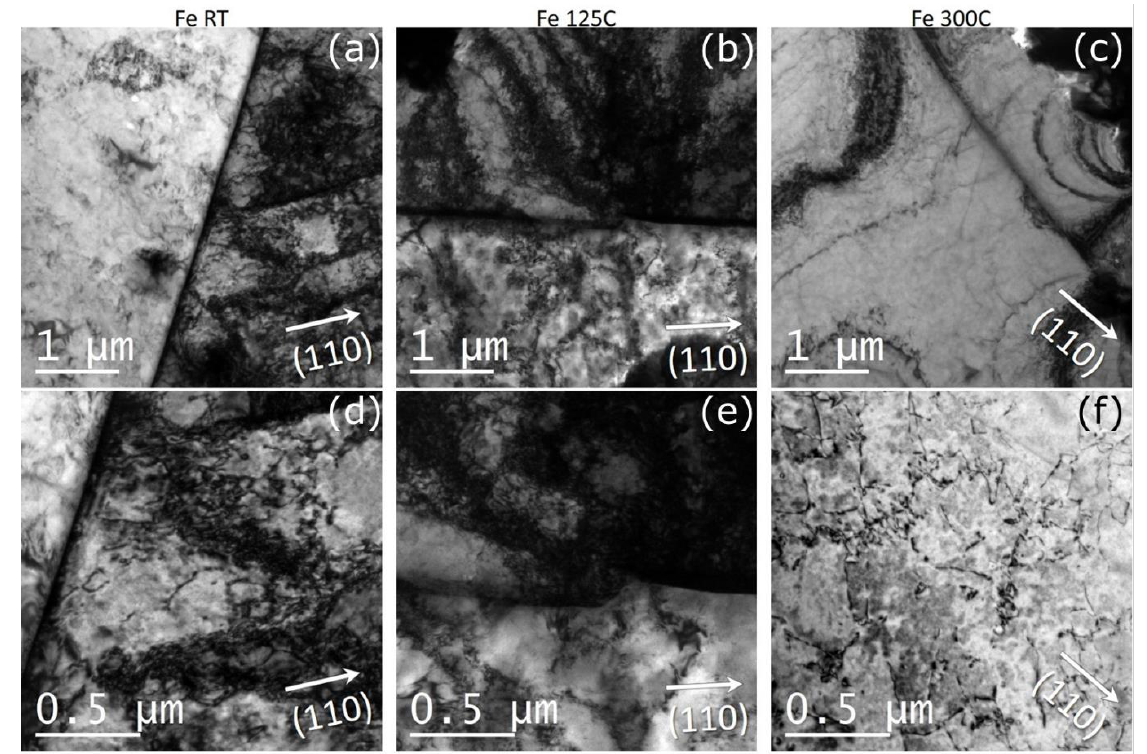
Figure 1. TEM micrographs showing typical dislocation patterns in plastically deformed Fe. ( a , d )—deformed at room temperature, ( b , e ) deformed 125 °C, ( c , f ) deformed at 300 °C.